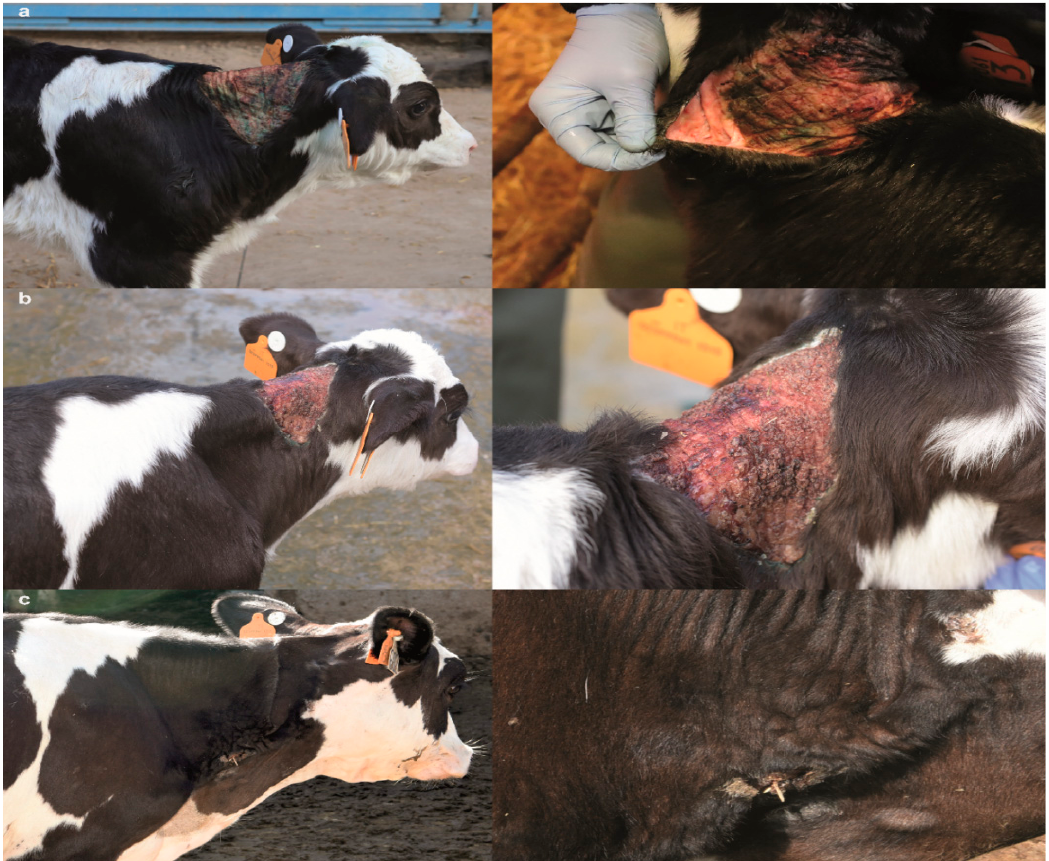
Figure 1. Neck skin lesions of the classical Ehlers – Danlos syndrome (cEDS)-affected Holstein calf. ( a ) Calf age = 3 days: severe, extensive ulceration secondary to minor trauma; note the spontaneous detachment of the skin from the subcutaneous tissue. ( b ) Calf age = 29 days: atrophic scarring; note the scabby and crustose wound with the edges firmly embedded in the subcutaneous tissue. ( c ) Calf age = 7 months: papyraceous scars and cutis laxa.